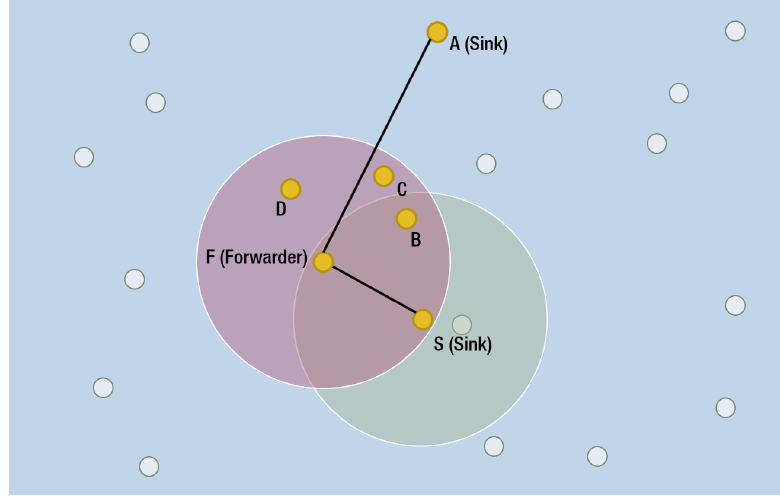
Figure 8. Packet transmission in Directional Flooding-Based Routing (DFR)